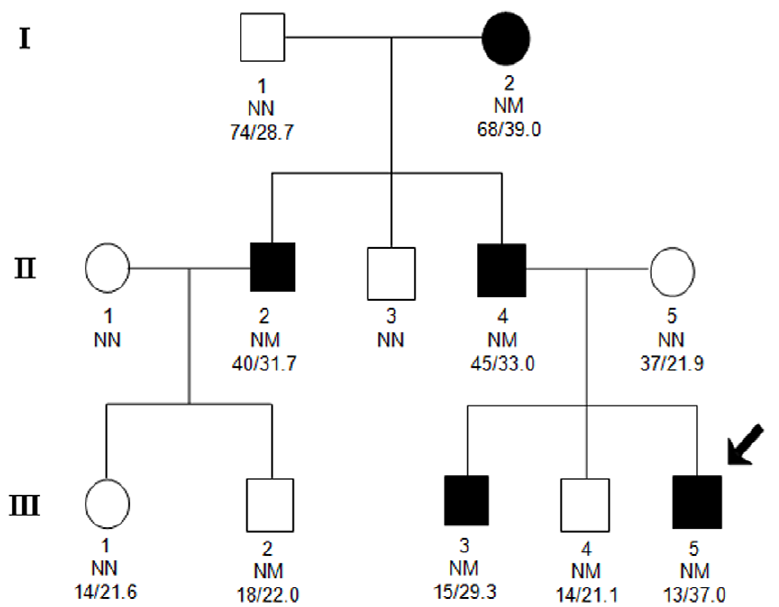
Figure 2. Pedigree of Czech family carrying the -151 GHSR promoter variant. Filled symbols indicate obese subjects. For subjects above 18 years obesity was defined as a BMI $ 30 kg/m 2 , obesity in children was defined as a BMI above 97th percentile for sex and age according to the Czech national references (27). The index patient is indicated by the arrow. The roman number refers to the generation and the text below each individual represents the following: family-specific identification number; genotype NN, no mutation; NM, heterozygous GHSR -151C . T mutation and age (years)/maximal BMI (kg/m 2 ). All persons are represented with their maximal BMI and age at maximal BMI. CZ-X-Y (Czech family, generation X and person ID Y). CZ-II-3 has not been available for a medical exam or interview, but is reported by family members to be lean.